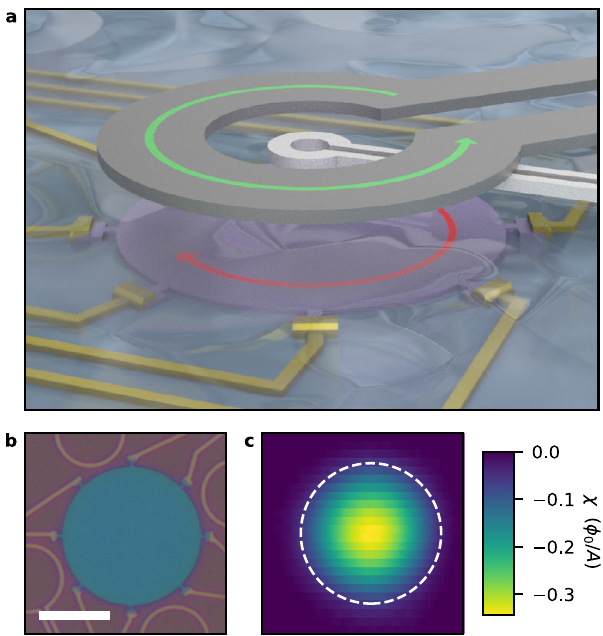
Fig. 1 | Magnetic measurement of ionic gated MoS 2 . a A fl ake of MoS 2 (shown in purple)onaSiO 2 /Sisubstrateispatternedintoadiskandcoveredbyaspin-coated ionicgel.TheSQUIDpickuploop(showninsilver),withconcentric fi eldcoil(shown in dark gray) is approached to the sample. A current in the fi eld coil produces a magnetic fi eld, which results in an opposing screening current in the super- conductor. The strength of the screening current is magnetically detected by the pickup loop. b Optical image of device A, a 20 μ m diameter circular MoS 2 device (blue) with electrical contacts. The scale bar is 10 μ m. c Image of the magnetic response of thedeviceshownin b at4K.Thewhitedashed circlehasadiameterof 20 μ m and indicates the device